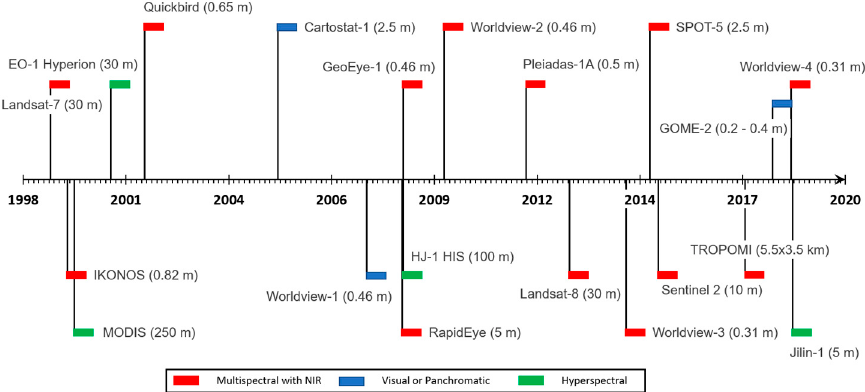
Figure 1. List of satellite sensors and their spatial resolutions since 1999. Note: Satellites with a multispectral sensor typically provide visual or panchromatic bands. NIR: near infrared .